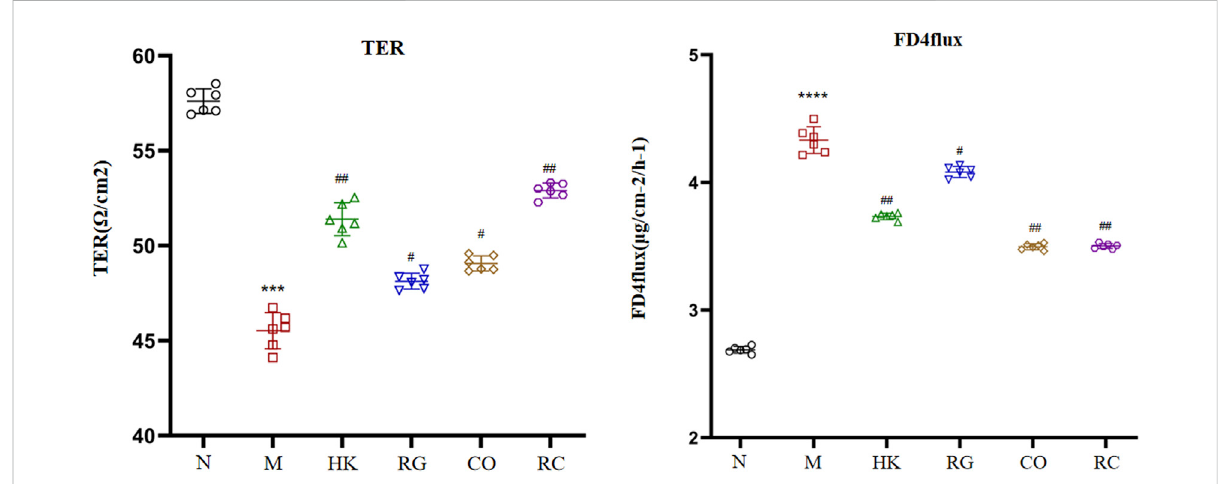
FIGURE 3 Indexes of the intestinal barrier function. (Data are means ± SD. **** p < 0.0001 and *** p < 0.001 vs . normal group; ## p < 0.01 and # p < 0.05 vs . model group. n =